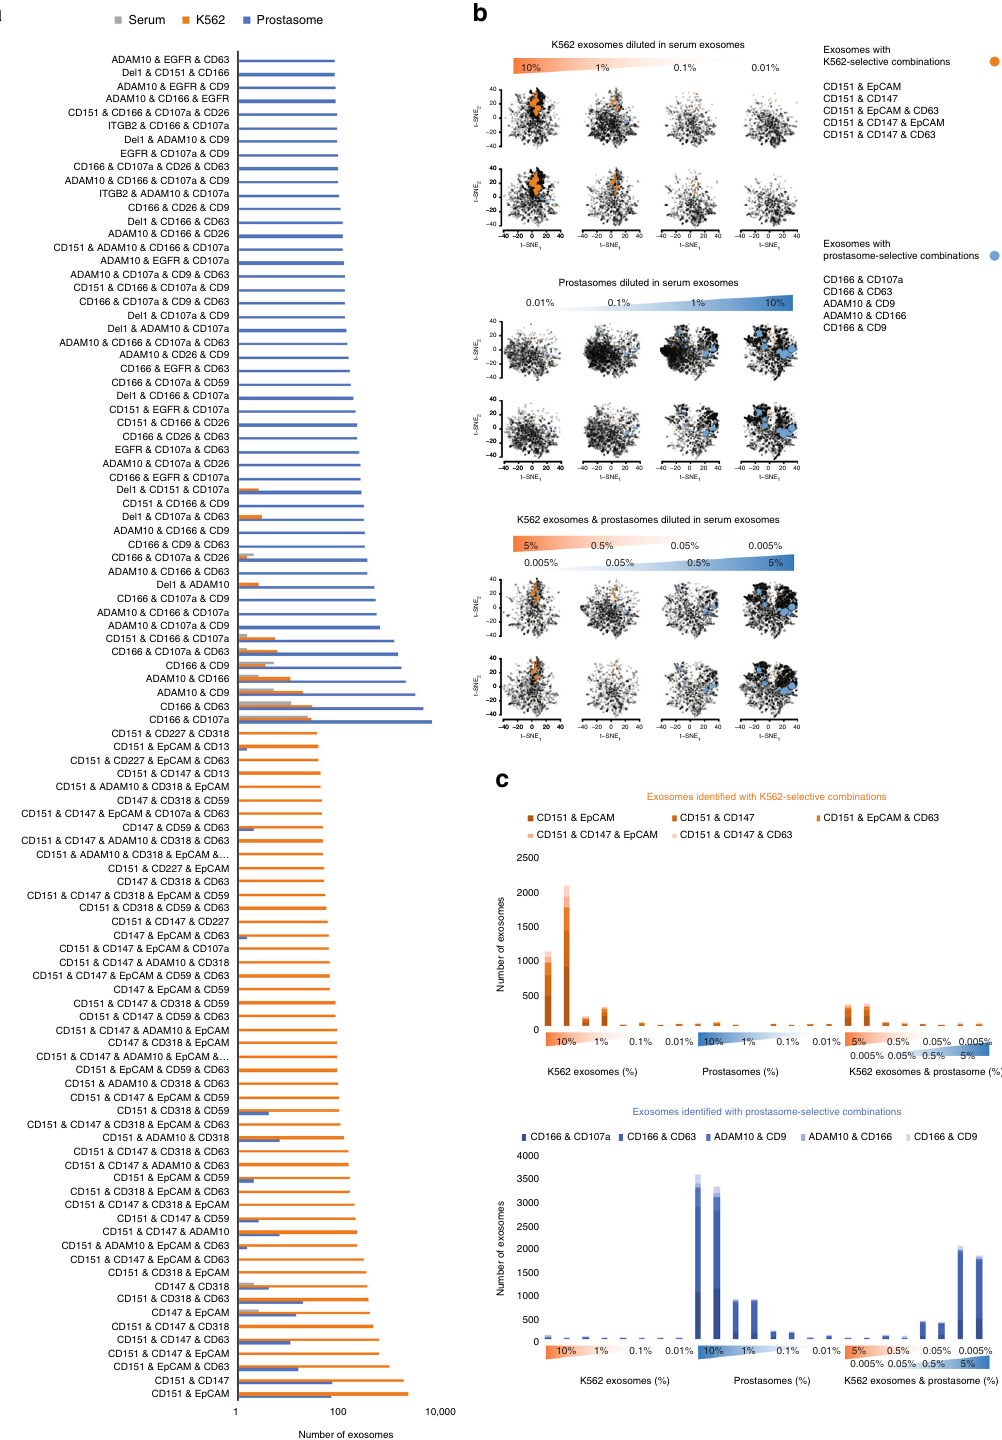
Fig. 5 Quanti fi cation of exosomes from different sources according to their surface protein combinations, as revealed by PBA. a Protein combinations selective for either K562 exosomes (orange) or prostasomes (blue), compared to exosomes from serum (gray), were sorted based on the number of exosomes with speci fi c combinations. Here, the top 50 for each exosome are displayed. b , c Serial dilution of K562 exosomes or prostasomes spiked in serum exosomes were quanti fi ed using K562- or prostasomes-selective combinations, respectively. The exosomes identi fi ed with either K562- or prostasome-selective combinations are indicated by orange and blue fi lled circles in the tSNE plots in b , and with orange and blue bars, respectively, in the bar plots in c . The sizes of the colored circles in ( b ) are proportional to the number of exosomes with the same protein combination. Each two vertically adjacent tSNE plots and two horizontally adjacent bars are illustrating two